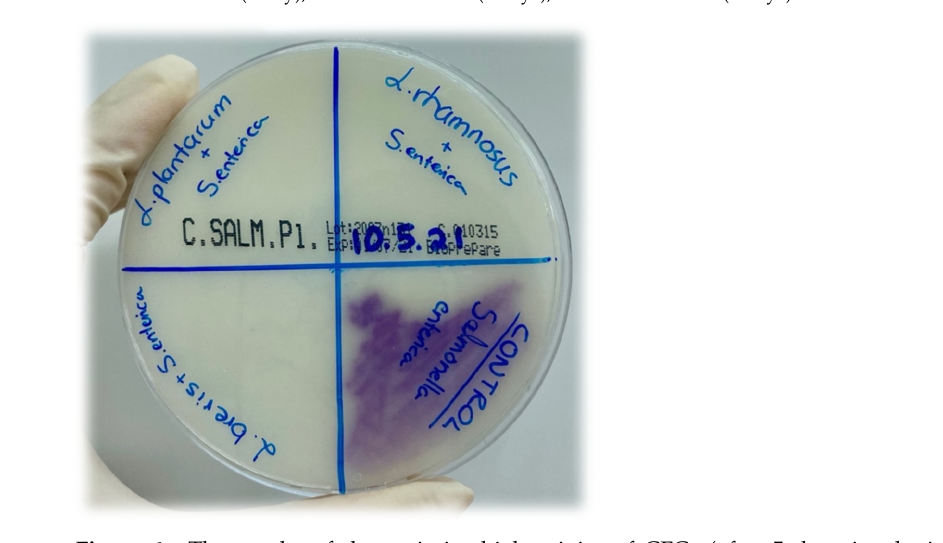
Figure 6. The results of the antimicrobial activity of CFCs (after 5 days incubation) of three LAB species ( Levilactobacillus brevis, Lactiplantibacillus plantarum, Lacticaseibacillus rhamnosus ) against pathogenic bacteria Salmonella enterica ATCC14028.